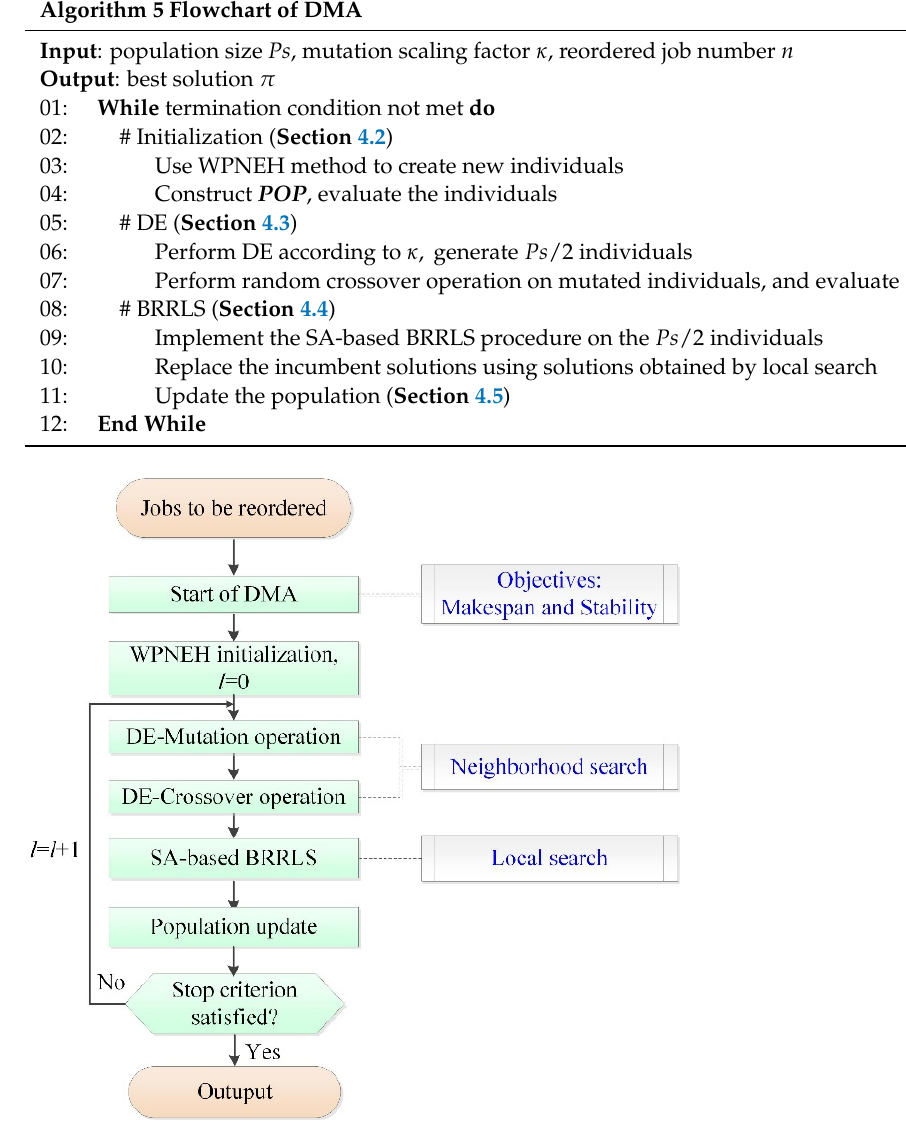
Figure 6. Flow diagram of DMA.